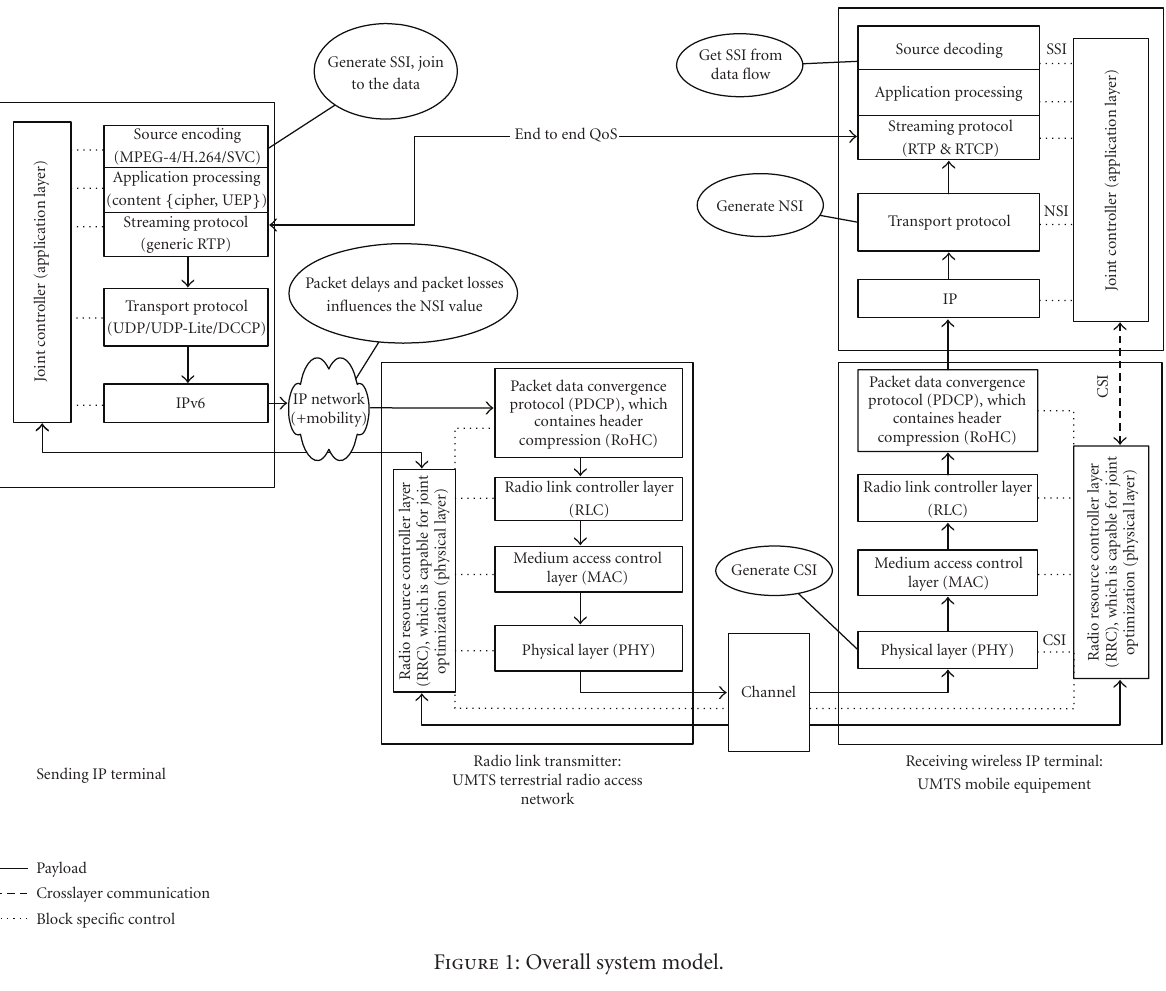
Figure 1: Overall system